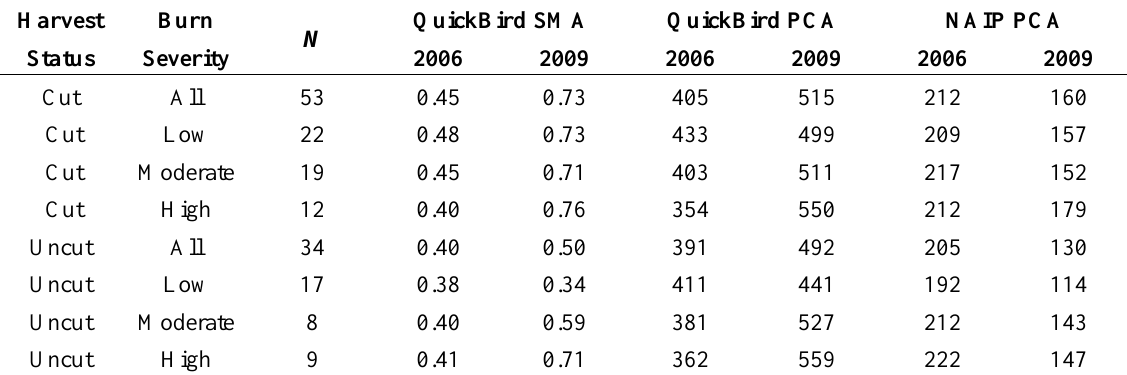
Table 4. Mean soil exposure and disturbance by salvage cut/uncut and burn severity class from remotely sensed imagery of the School Fire. n is number of units in each class. The Spectral Mixture Analysis (SMA) results from the QuickBird imagery are mean soil exposure (x100%). The QuickBird and NAIP Principal Component Analysis (PCA) values are continuous PC1 values for